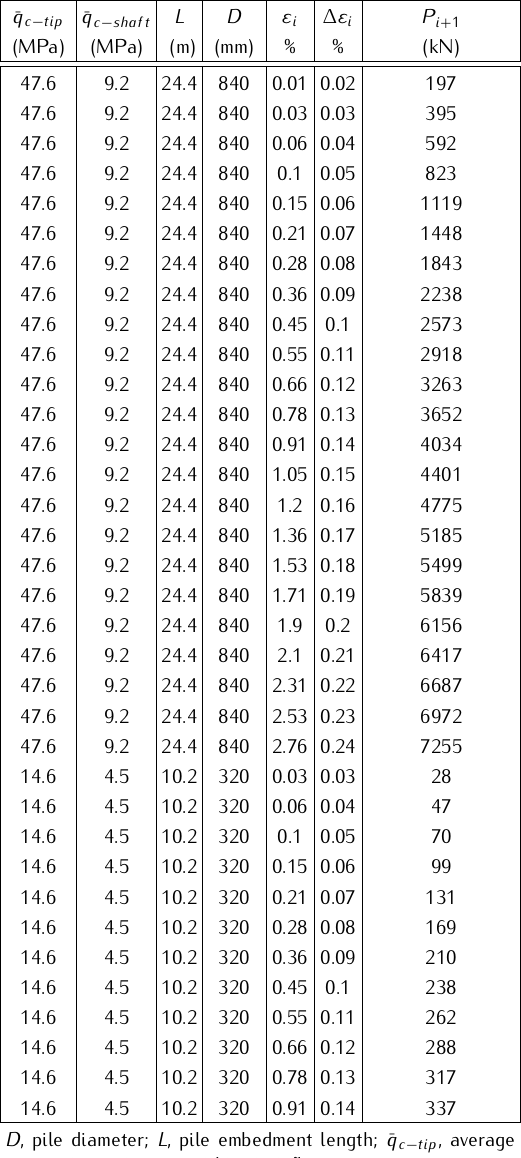
Table 2. A sample of data input setting used to develop the bored piles ANN model.